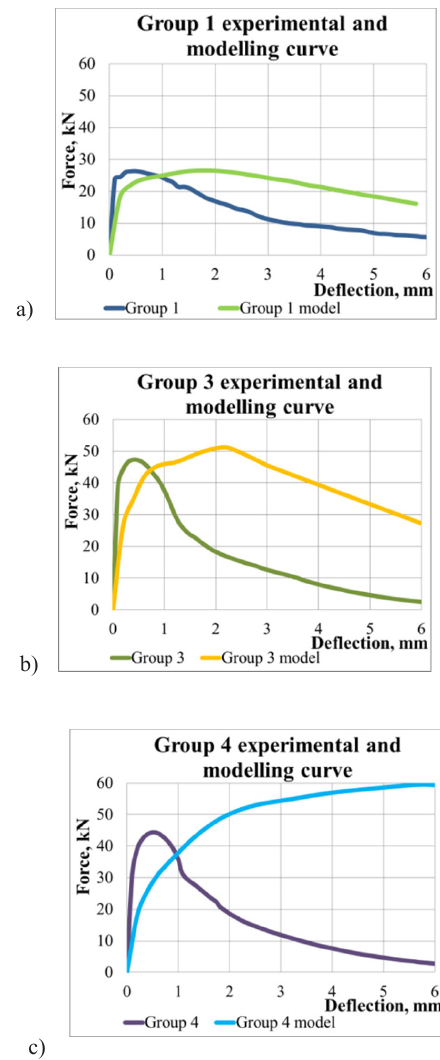
Fig. 12. The average experimental result and modelling curve for Group 1 (a); Group 3 (b); Group